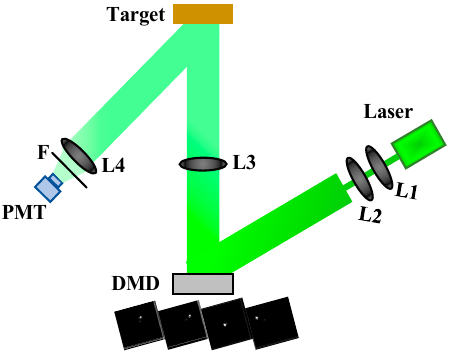
Figure 6. Schematic diagram of the experimental setup. A 532 nm laser beam passed through an expanding system which consisted of lenses L1 and L2, and then was reflected by a digital micromirror device (DMD). The patterns loaded onto the DMD were an atmospheric modulation matrix simulated by the Monte Carlo (MC) simulation. A lens, L3, was placed between the DMD and the target to image the modulation patterns on the target. The reflected light from the target reached the photomultiplier tube after being focused by the optical collecting system, L4, and filtered by the spectral sheet, F. The detection signal from the photo multiplier tube (PMT) was used for image reconstruction.